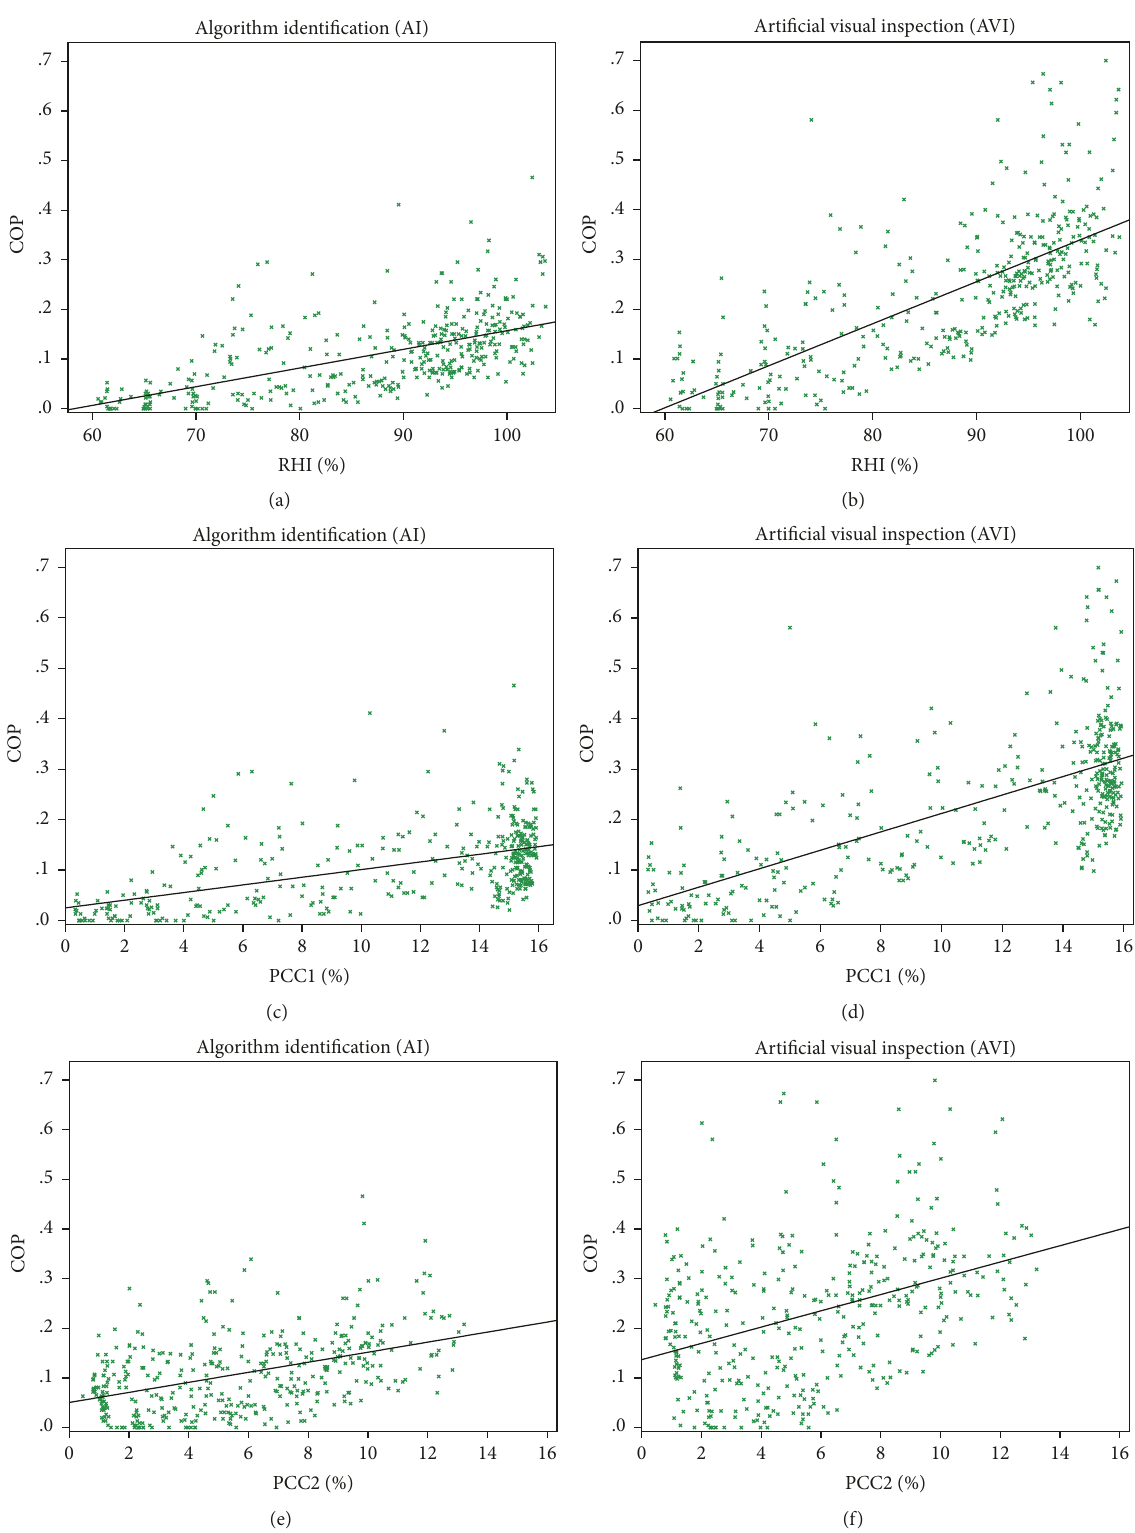
Figure 7: Plot of COP fraction versus the mean of RHI, PCC1, and PCC2 values calculated in 1 ∘ × 1 ∘ grid box. (a), (c), and (e) represent AI. (b), (d), and (f) represent